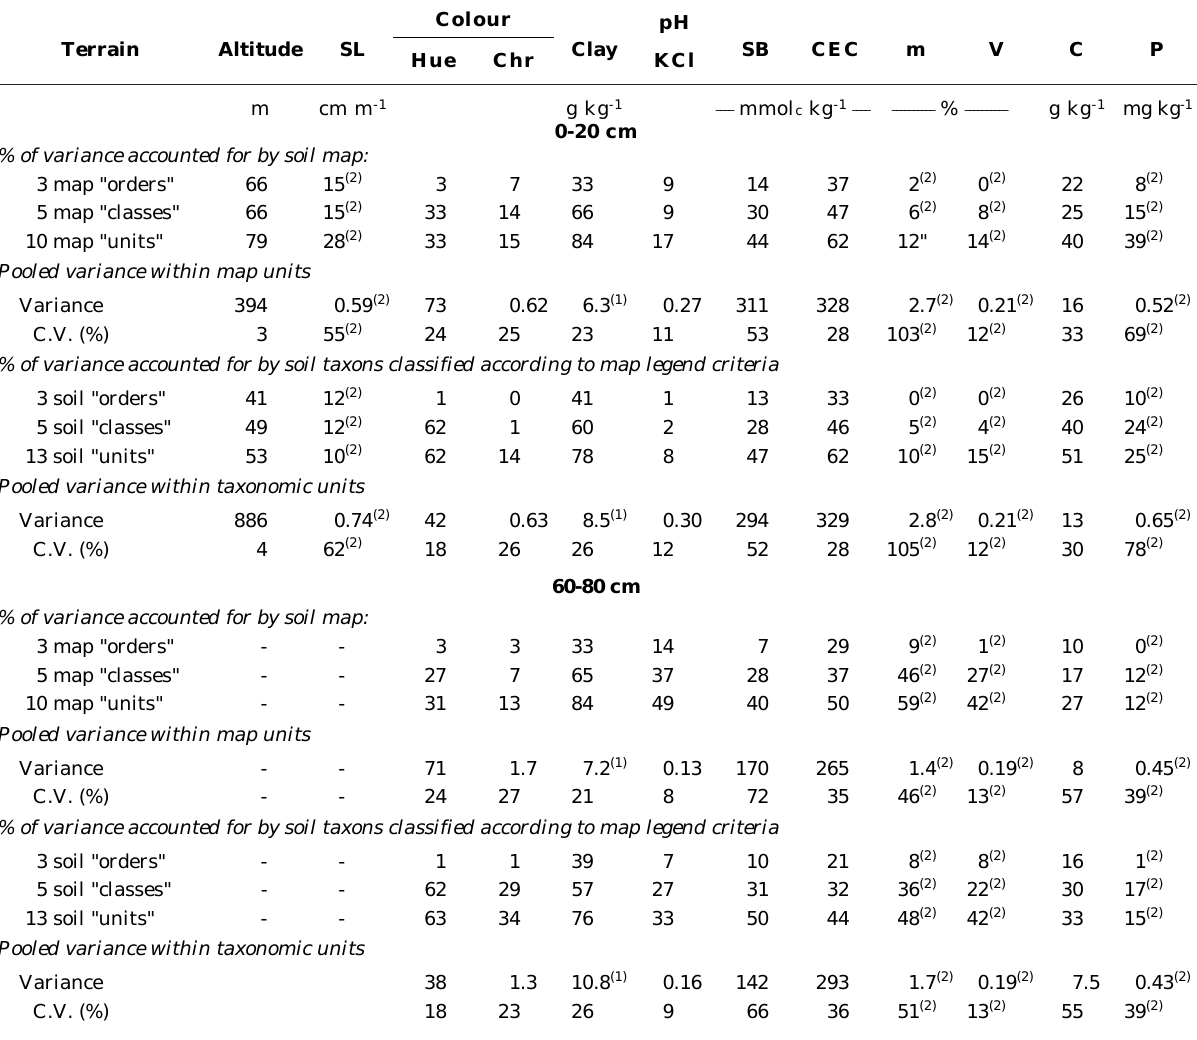
Table 6. Variance by soil map units and soil taxons for 166 sites in the Araras